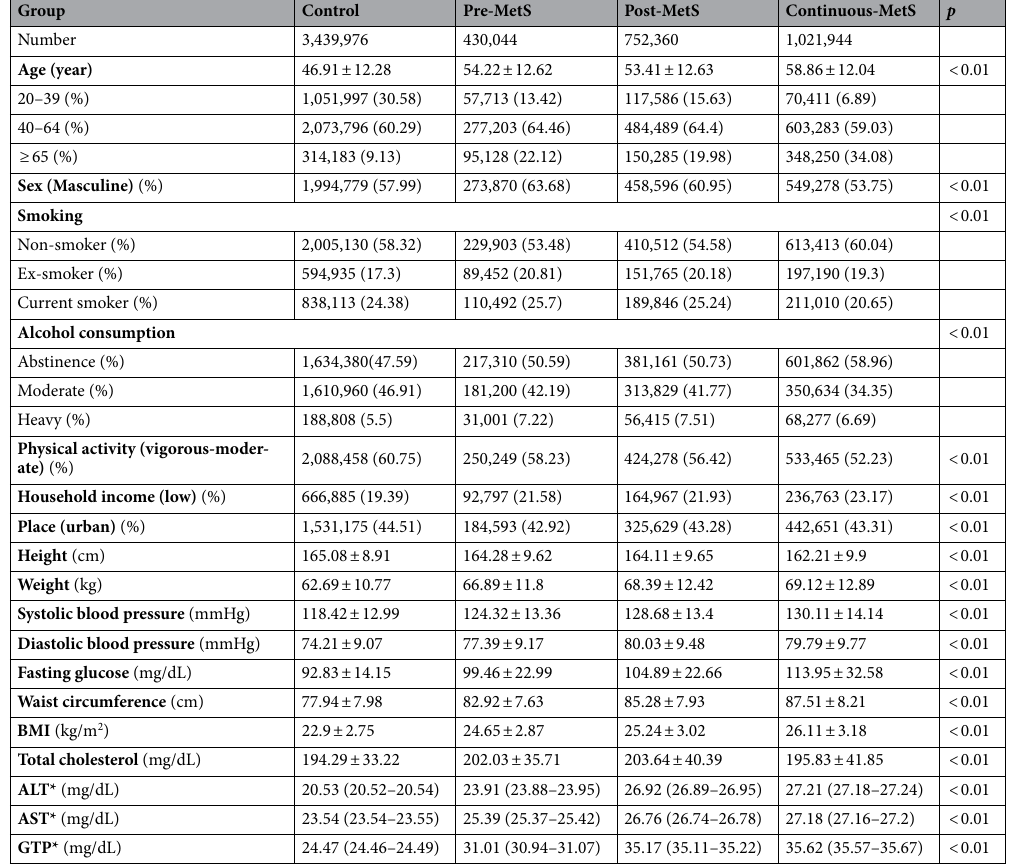
Table 1. Characteristics of the study population.